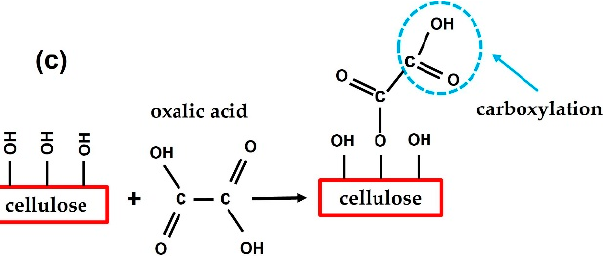
Figure 1. ( a ) FTIR spectra and ( b ) carboxylic content of the original bleached eucalyptus pulp (BEP) and the CMNF obtained from pulp treated with 25 wt.% and 50 wt.% oxalic acid. ( c ) Schematic diagram of cellulose carboxylation.